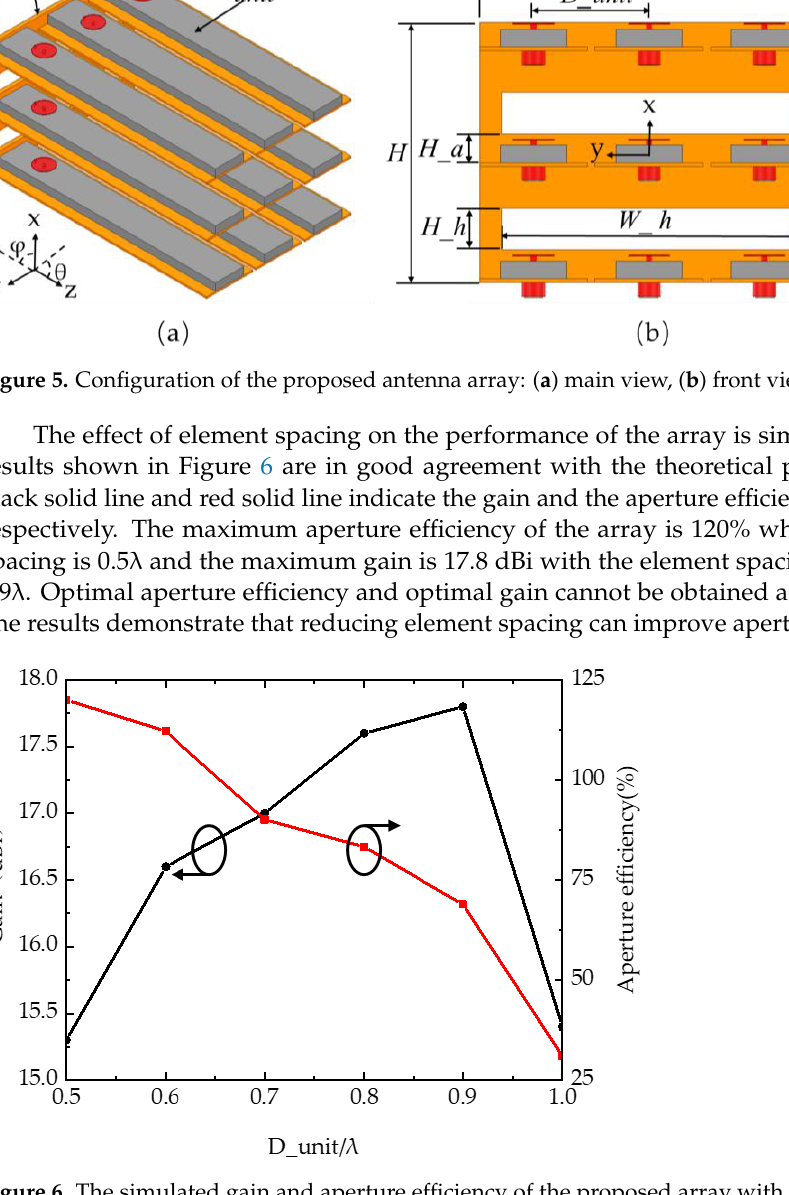
Figure 4. ( a ) Simulated E-plane and H-plane radiation patterns of the element antenna. ( b ) Simu- lated reflection coefficient of the element antenna. ( c ) E-field distribution in the dielectric slab and free space.